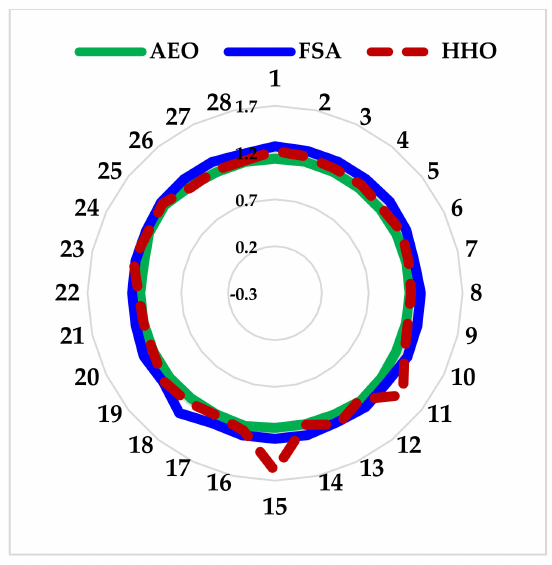
Figure 8. Fitness for cost of energy without DSM at 60% REF and 0%